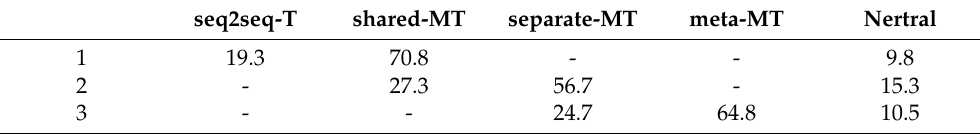
Table 3. Subjective AB preference score(%) of synthesized Tibetan speech samples with p <